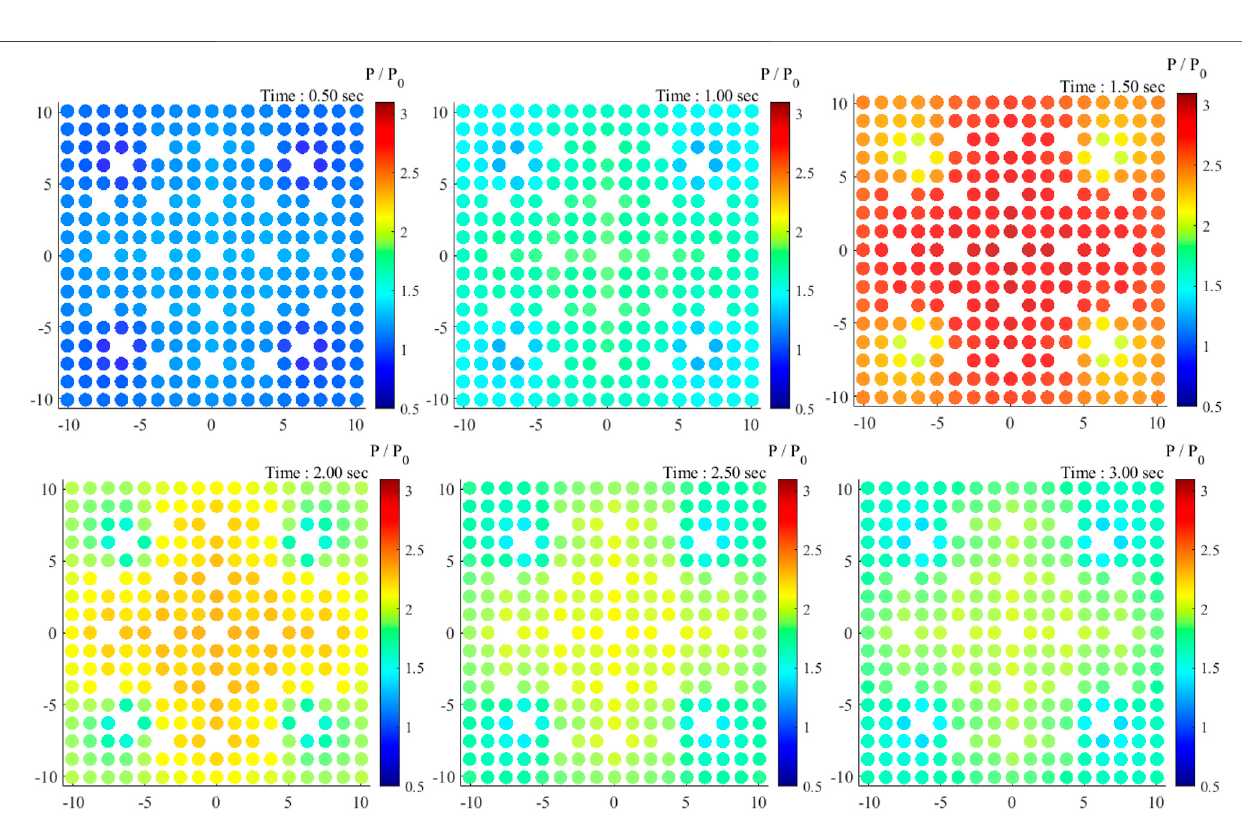
FIGURE 7 | Time-dependent pin-power distribution from 0.5 to 3 s.